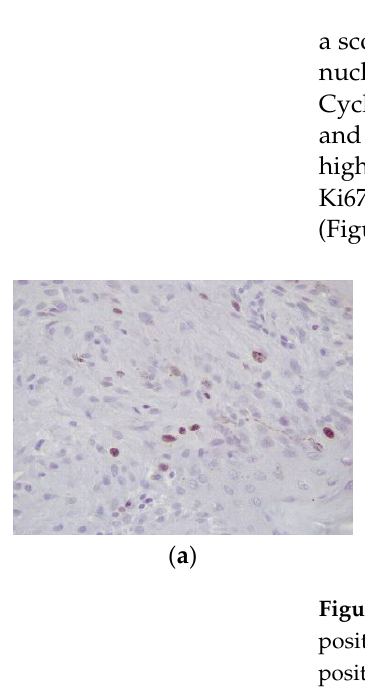
Table 1. Summary of immunohistochemical results based on clinical types of 55 sarcoids.